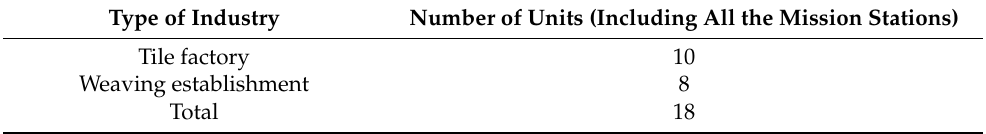
Table 1. Industrial enterprises of Basel Mission in Malabar. Type of Industry Number of Units (Including All the Mission Stations) Tile factory 10 Weaving establishment 8